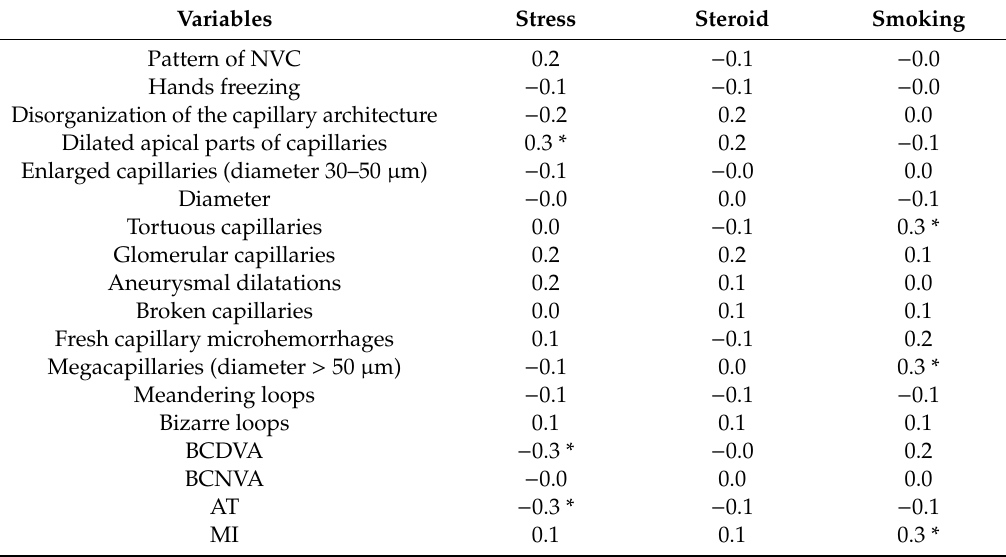
Table 5. Correlation between general risk factors and NVC and functional results in central serous chorioretinopathy (CSC) patients (r Spearman’s